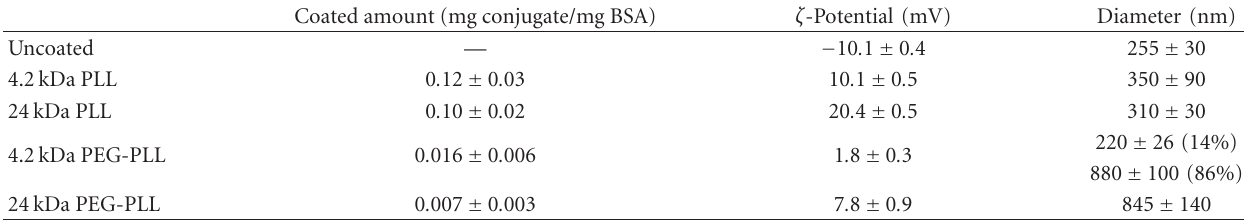
Table 1: Selected characteristics of prepared NPs: (i) e ffi ciency of PLL and PEG-PLL coating on BSA NPs, (ii) ζ -potential, and (iii) average size (average ± standard deviation, n ≥ 5). Note that the NPs from 4.2kDa PLL-PEG coating gave two size populations with relative ratios of 14% and